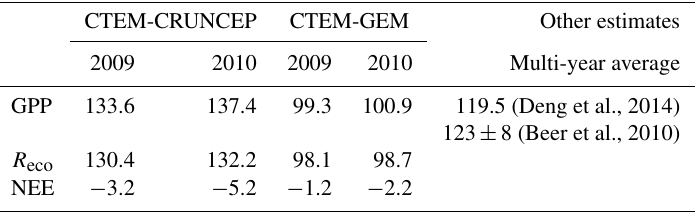
Table 4. Annual GPP, R eco , and NEE (PgCyr − 1 ) from CTEM-CRUNCEP and CTEM-GEM for the transient simulations. The transient simulation was initialized from the spin-up simulations using varying CO 2 concentrations and